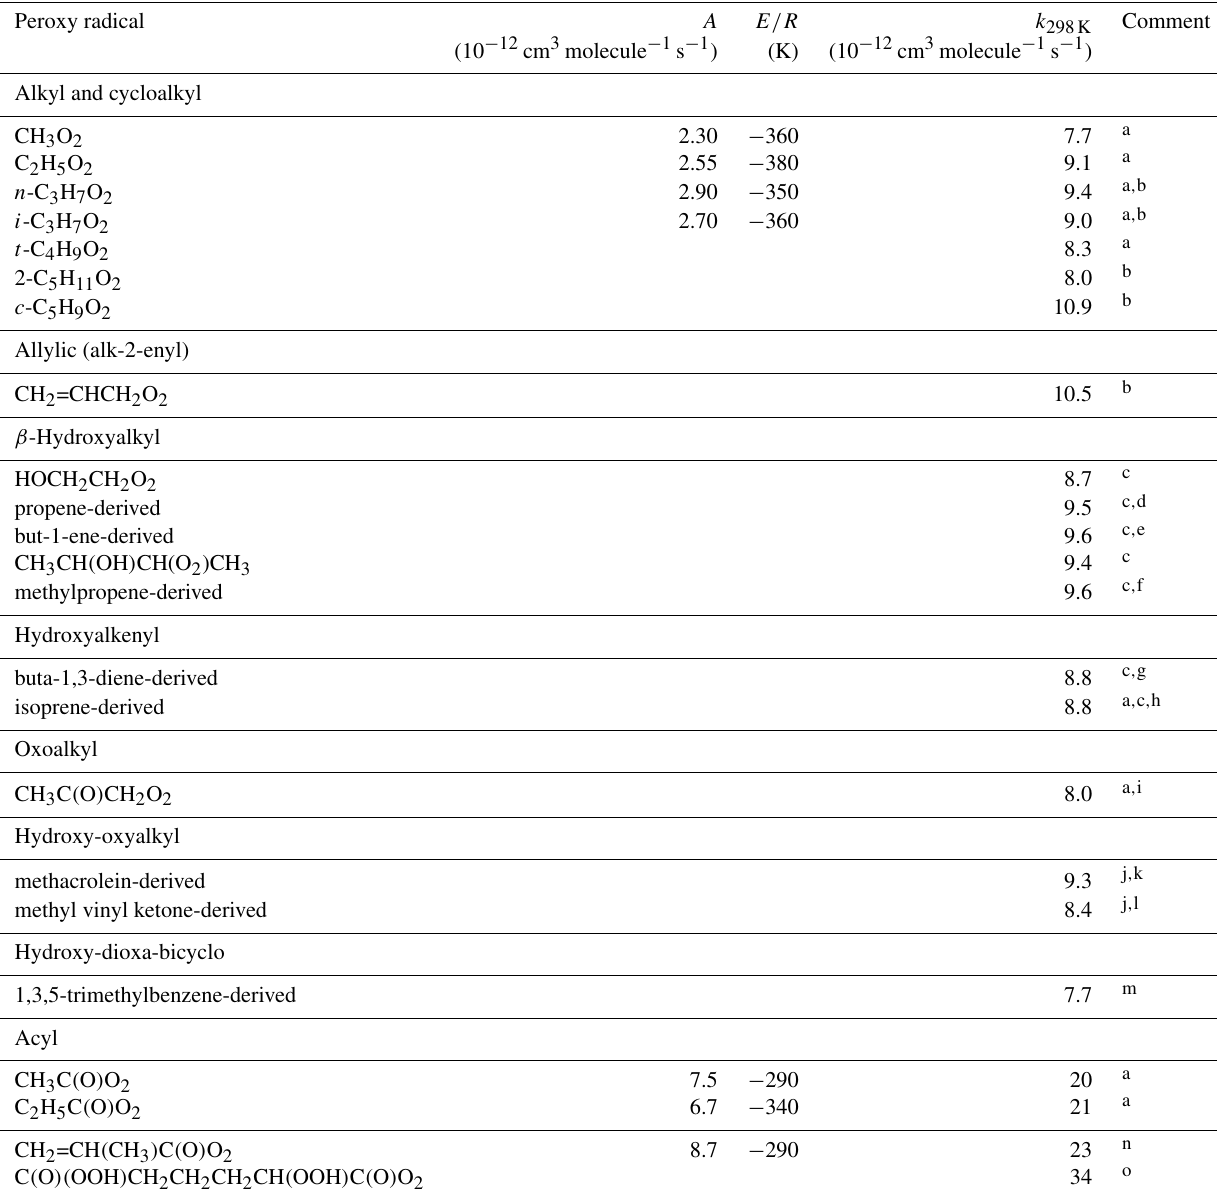
Table 1. Kinetic data for the reactions of hydrocarbon and oxygenated peroxy radicals with NO. Where available, the temperature dependence is given by k = A exp ( − E/RT )